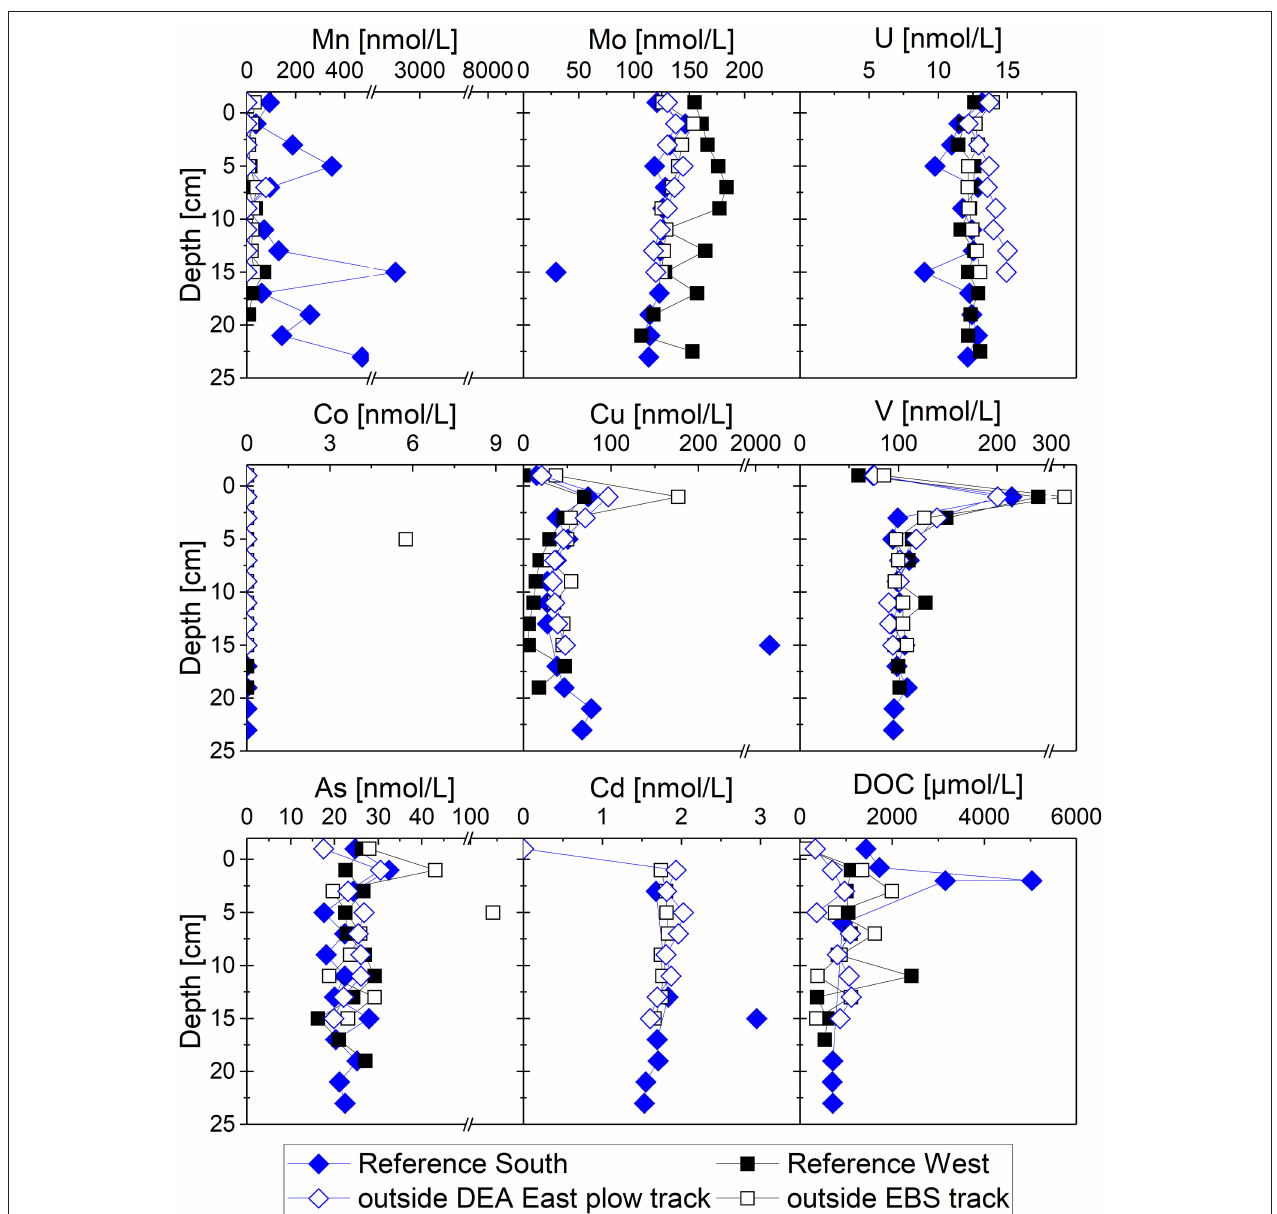
FIGURE 7 | Bottom water and pore water element profiles of the undisturbed sites. The uppermost values refer to bottom water concentrations measured in the supernatant retrieved above the sediment surface in the MUC liner.